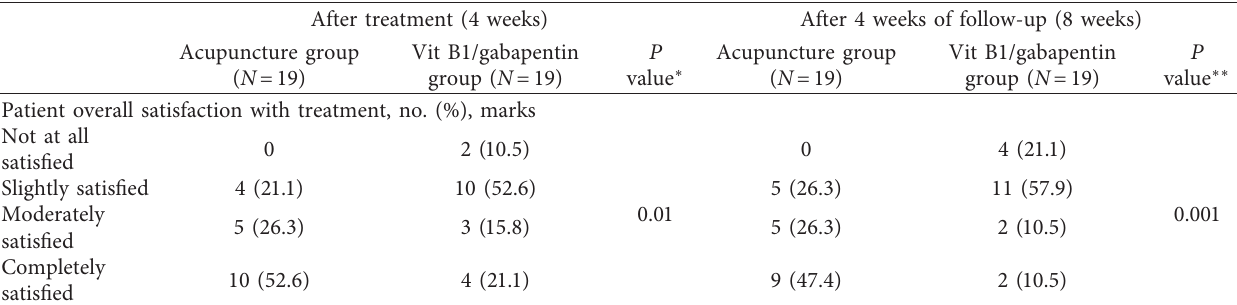
Table 5: Comparison of patient overall satisfaction with treatment between two